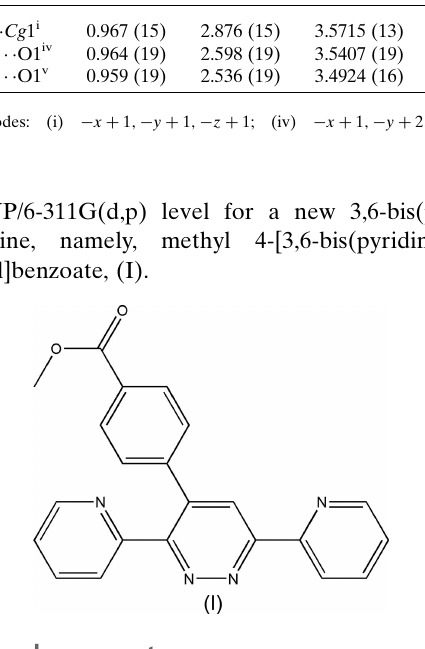
Table 1 Hydrogen-bond geometry (A˚ , (cid:5) ). Cg 1 is the centroid of pyridyl ring A (atoms N1/C1–C5). D —H (cid:2)(cid:2)(cid:2) A